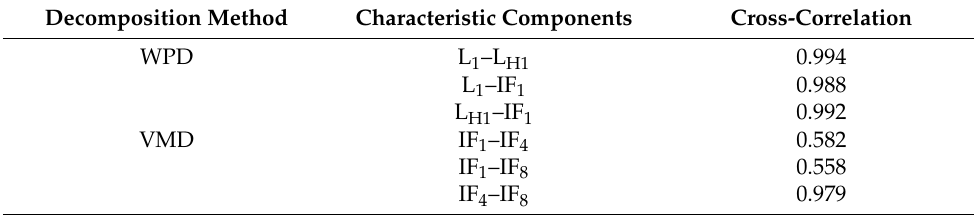
Table 2. Cross-correlation analysis of highly correlated features based on WPD and